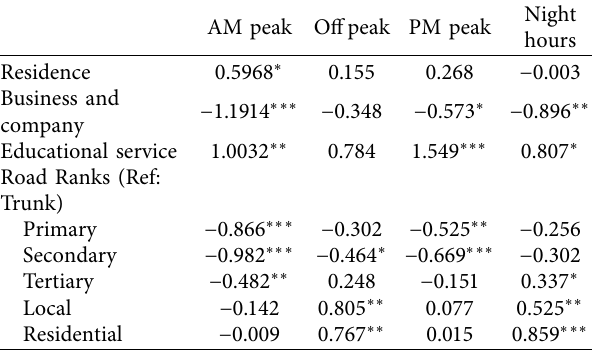
service, and catering